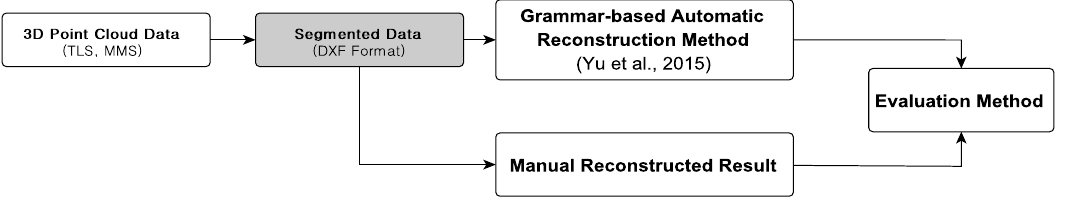
Figure 1: Proposed evaluation method using model attributes for automatic 3D building